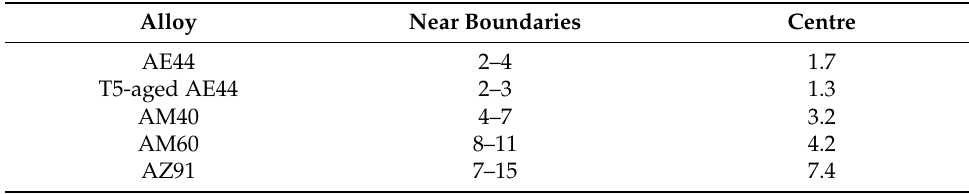
Table 3. Al solute concentration level (wt.%) in the α -Mg matrix obtained by